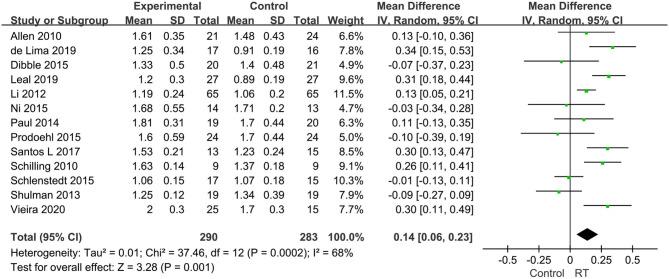
Forest plots of the effects of lower limb RT on gait performance—fast gait velocity in PD. CI, confidence interval.